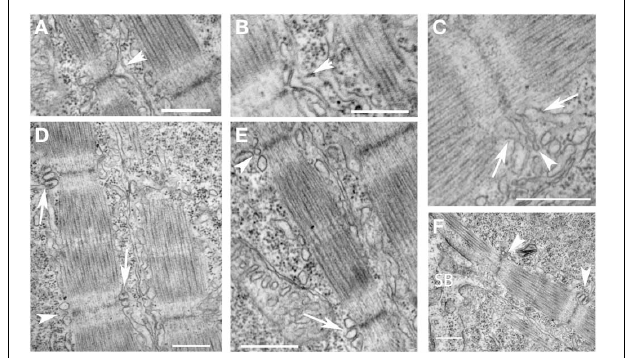
FIGURE 6 | Early organization of T tubules and junctional SR around newly-formed myofibrils. (A,B) T tubules formed from invaginations (arrowheads) of the sarcolemma overlying the Z disks of newly formed myofibrils. (C) The T tubules (arrowhead) were often initially quite narrow initially before increasing in volume later in development. The sarcoplasmic reticulum (arrows) organized on either side of invaginating T tubules but did not initially appear to be in direct contact. (D) Triads (two junctional SR domains surrounding a T tubule) formed overlying the Z disk of newly formed myofibrils progressing from immature structures with small, round T tubules (arrowheads) to more mature structures with larger, oval T tubules in close apposition to the junctional SR (arrows). (E) A higher magnification image of a new myofibril with an immature (arrowhead) and more mature (arrow) triad at either end of the sarcomere. (F) Triads (arrowheads) develop around newly formed Z disks as new sarcomeres are added adjacent to the somite boundary (SB). Scale bars are